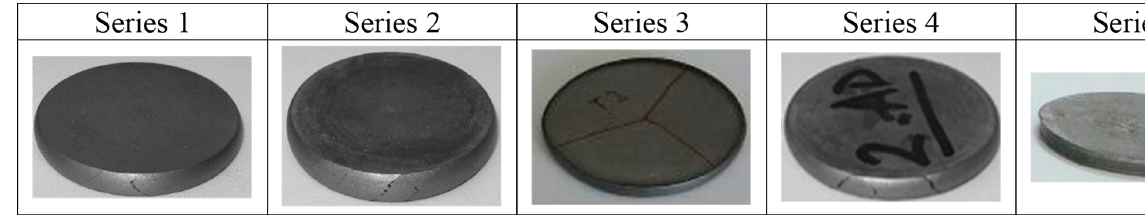
Figure 2. Shape of specimens at the instant of fracture